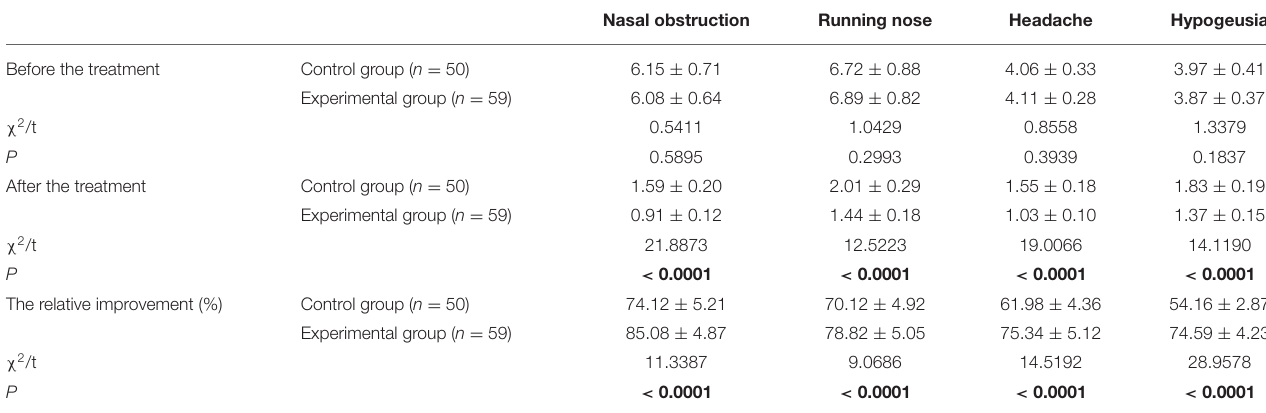
TABLE 4 | Comparison of clinical symptoms of patients between the two